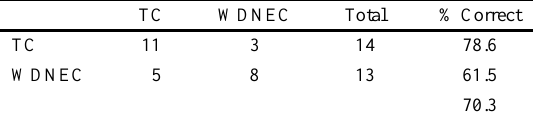
Fig. 2. Six nuclei (two upper rows) with low (0.11 [A.U.]) and six nuclei (two lower rows) with high (0.27 [A.U.]) values of HUCV.